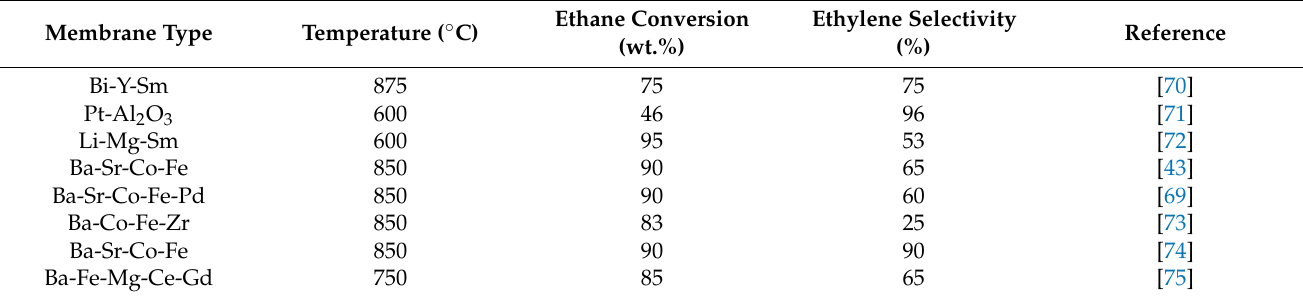
Table 5. Catalytic performance of the different membrane-based ethane ODH.